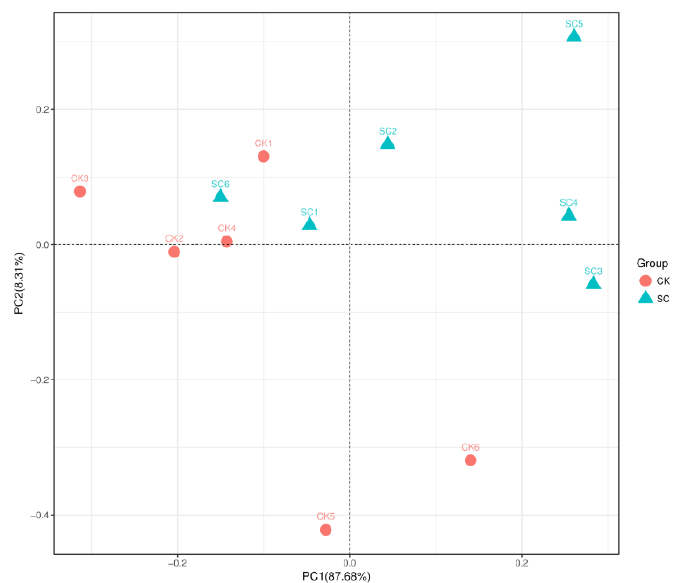
Figure 3. Principal component analysis of the nifH gene fragments of diazotroph at the OTU level. Abbreviations: SC, grasslands invaded by S. chamaejasme ; CK, uninvaded grasslands.